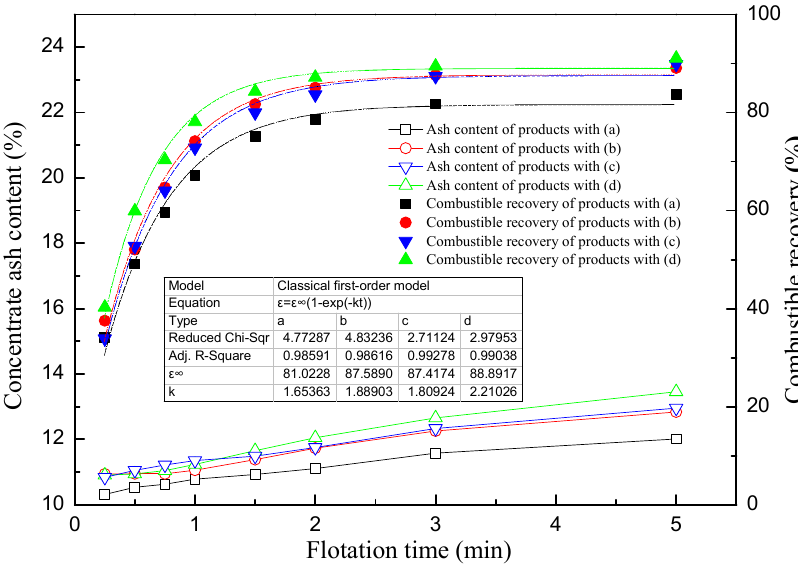
Figure 8. Flotation kinetics results in four types of flotation ( a ) Conventional flotation, ( b ) conditioning stage (HCCS), ( c ) separation stage (HCSS), and ( d ) whole stage (HCWS).